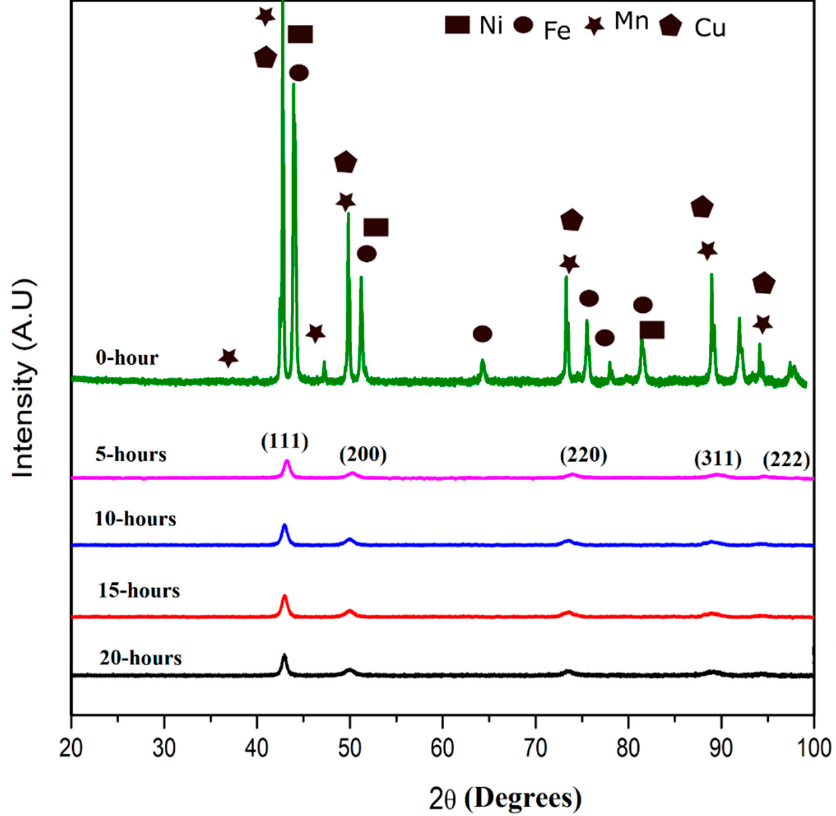
Figure 1. XRD patterns of the as-milled NiMnFeCu powders at various time intervals.